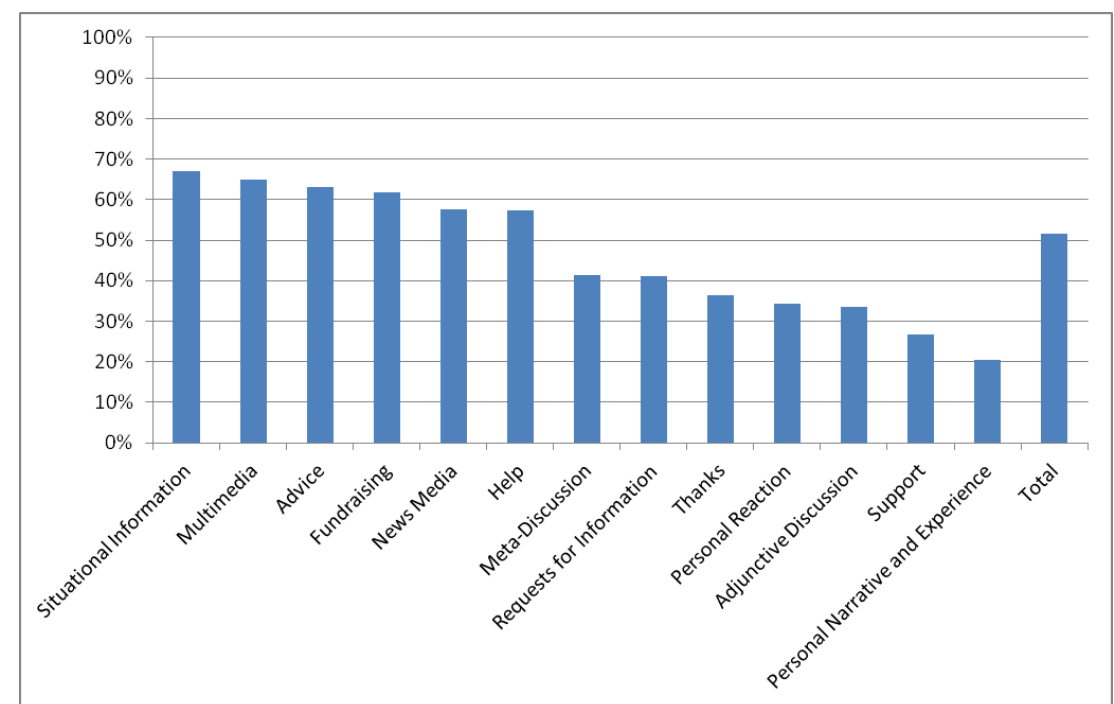
Fig. 2: Percentage of retweets amongst messages across the #qldfloods content